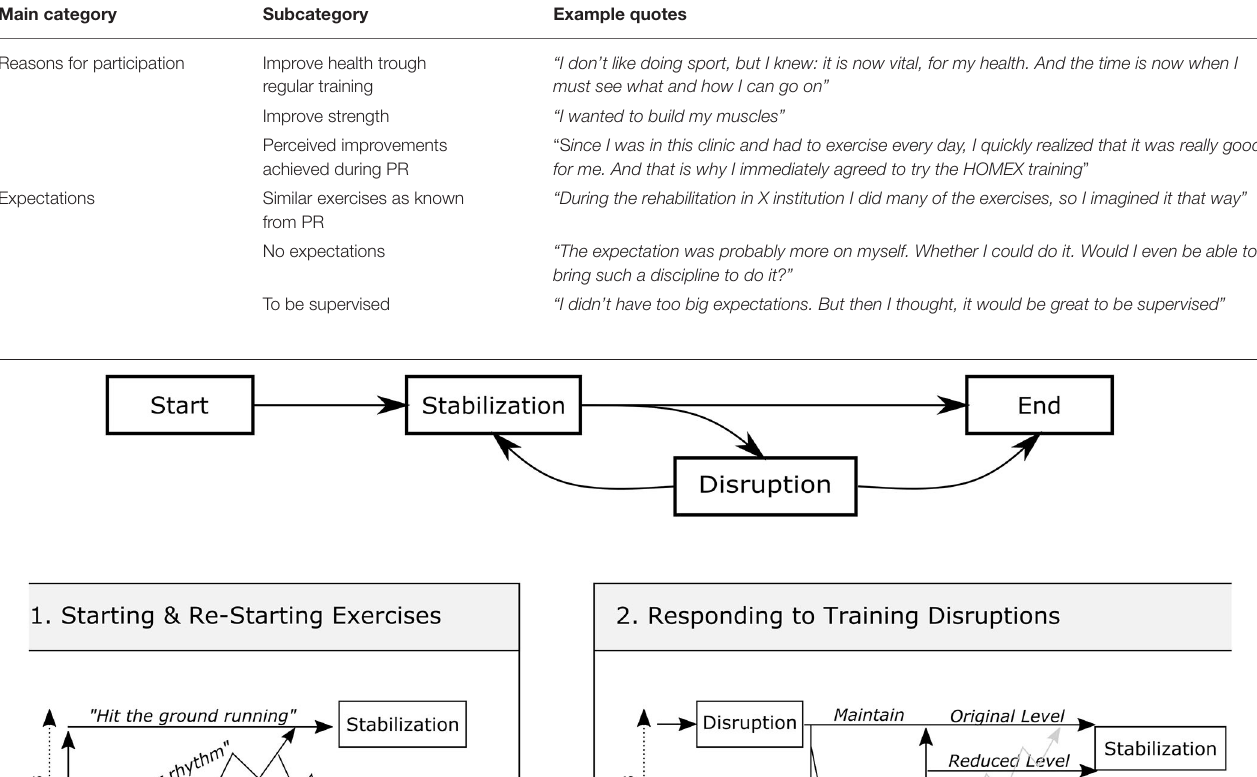
TABLE 2 | Results from interviews of patients: Thoughts before starting the training.